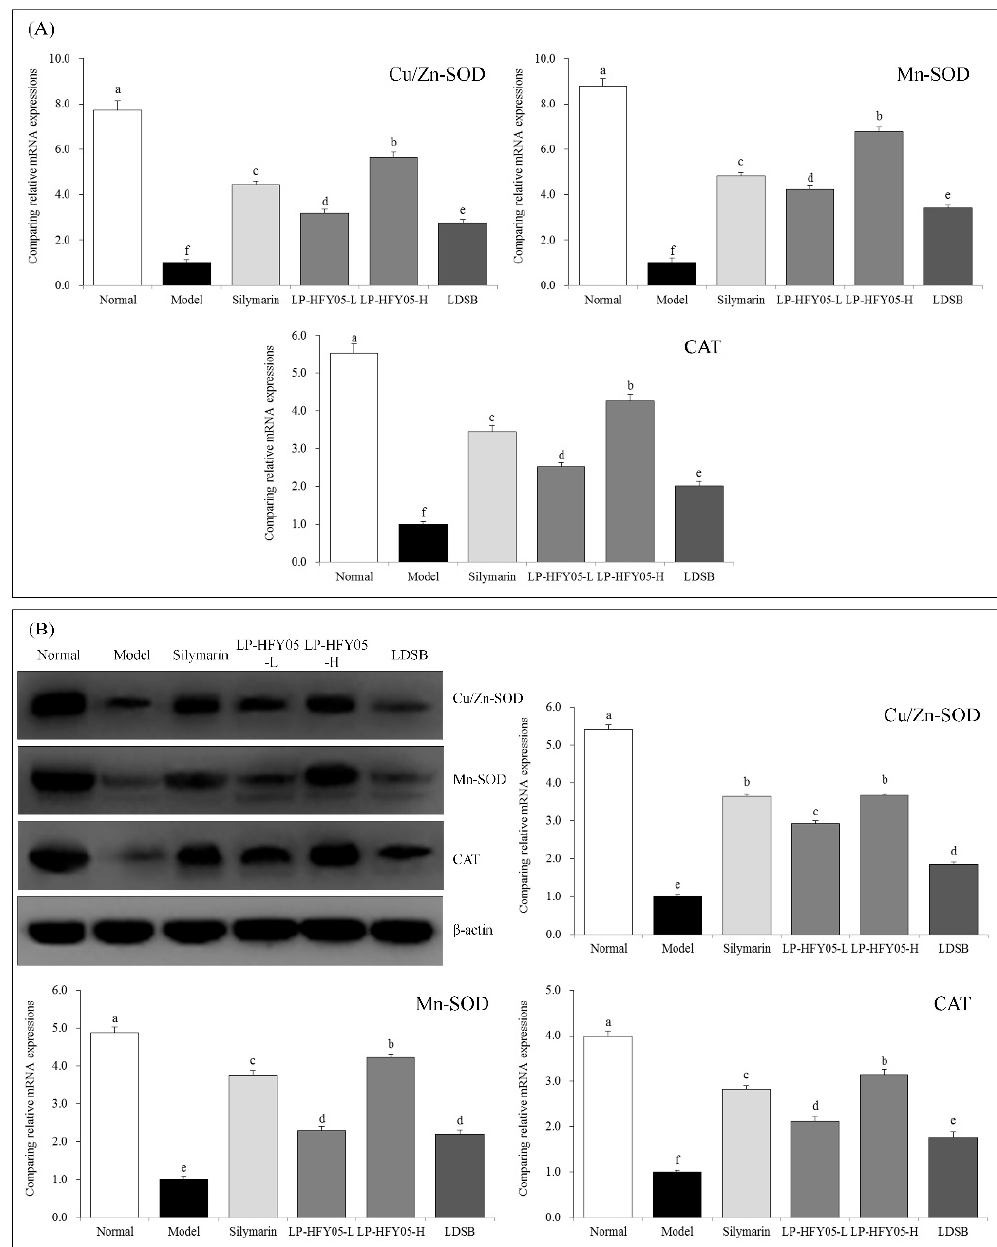
Figure 6. The Cu/Zn-superoxide dismutase (SOD), Mn-SOD, and catalase (CAT) mRNA ( A ) and protein ( B ) expression in hepatic tissues of mice. Sample data in each group come from a normal distribution. The difference in variance between the two groups was significant ( p < 0.05). a–f Mean values with different letters in the bar are significantly different ( p < 0.05) according to Tukey’s honestly significantly different test. Silymarin: Mice treated with silymarin (100 mg/kg), LP-HFY05-L: Mice treated with a low concentration of Lactobacillus plantarum HFY05 (1.0 × 10 8 CFU/kg), LP-HFY05-H: Mice treated with a high concentration of Lactobacillus plantarum HFY05 (1.0 × 10 9 CFU/kg), LDSB: Mice treated with Lactobacillus delbrueckii subsp. bulgaricus (1.0 × 10 9 CFU/kg).